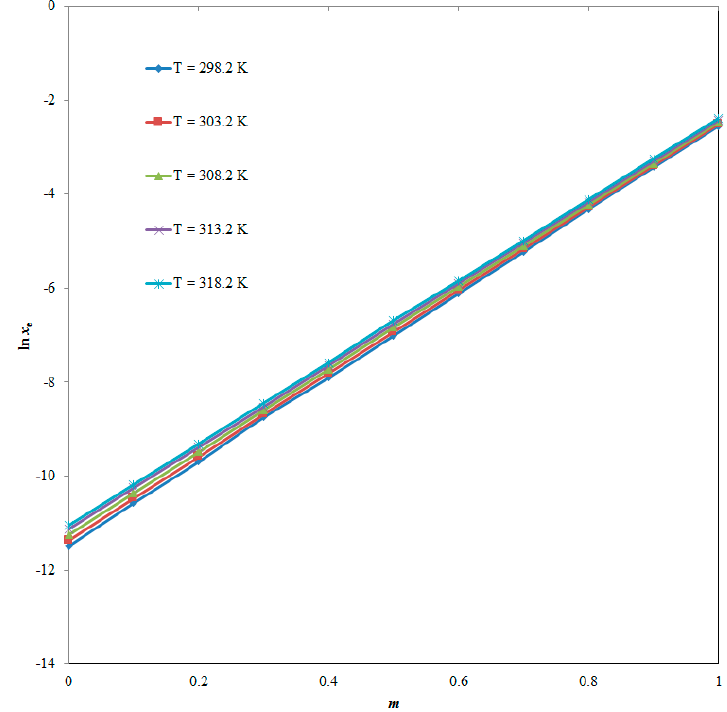
Figure 3. Effect of mass fraction of THP ( m ) on solubility of PPN at “ T = 298.2-318.2 K”. Figure 3. E ff ect of mass fraction of THP ( m ) on solubility of PPN at “ T = 298.2–318.2